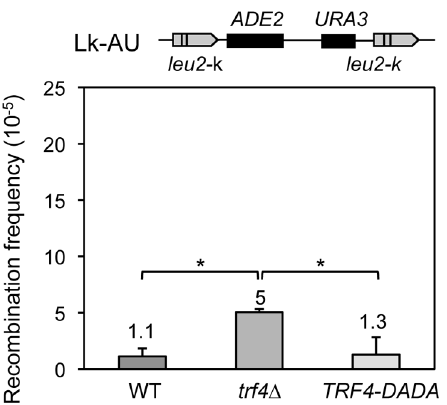
Figure 5. The hyperrecombination phenotype of trf4 D mutants is not dependent of its poly-adenylation catalytic domain. Recombination frequencies in AWT4-1C cells carrying the chromosomal leu2-k :: ADE2-URA3 :: leu2-k system and transformed with the pNOPPA- TA1L vector either empty ( trf4 D ) or carrying the wild-type TRF4 (WT) or the mutant TRF4-DADA alleles (TRF4-DADA). The average median value and SD of 3–4 fluctuation tests are shown. Asterisks indicate statistically significant differences, according to Student’s t-tests (*, P ,